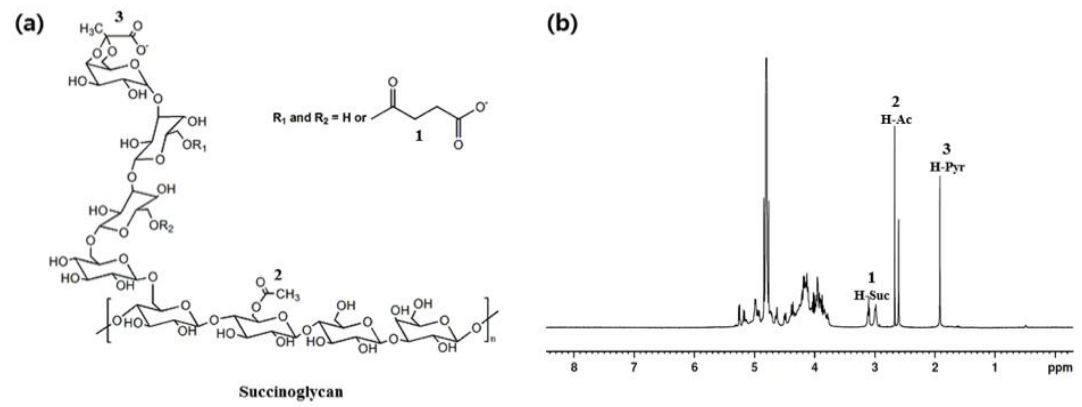
Figure 1. Structure of ( a ) succinoglycan and ( b ) 1 H-NMR spectrum of succinoglycan.